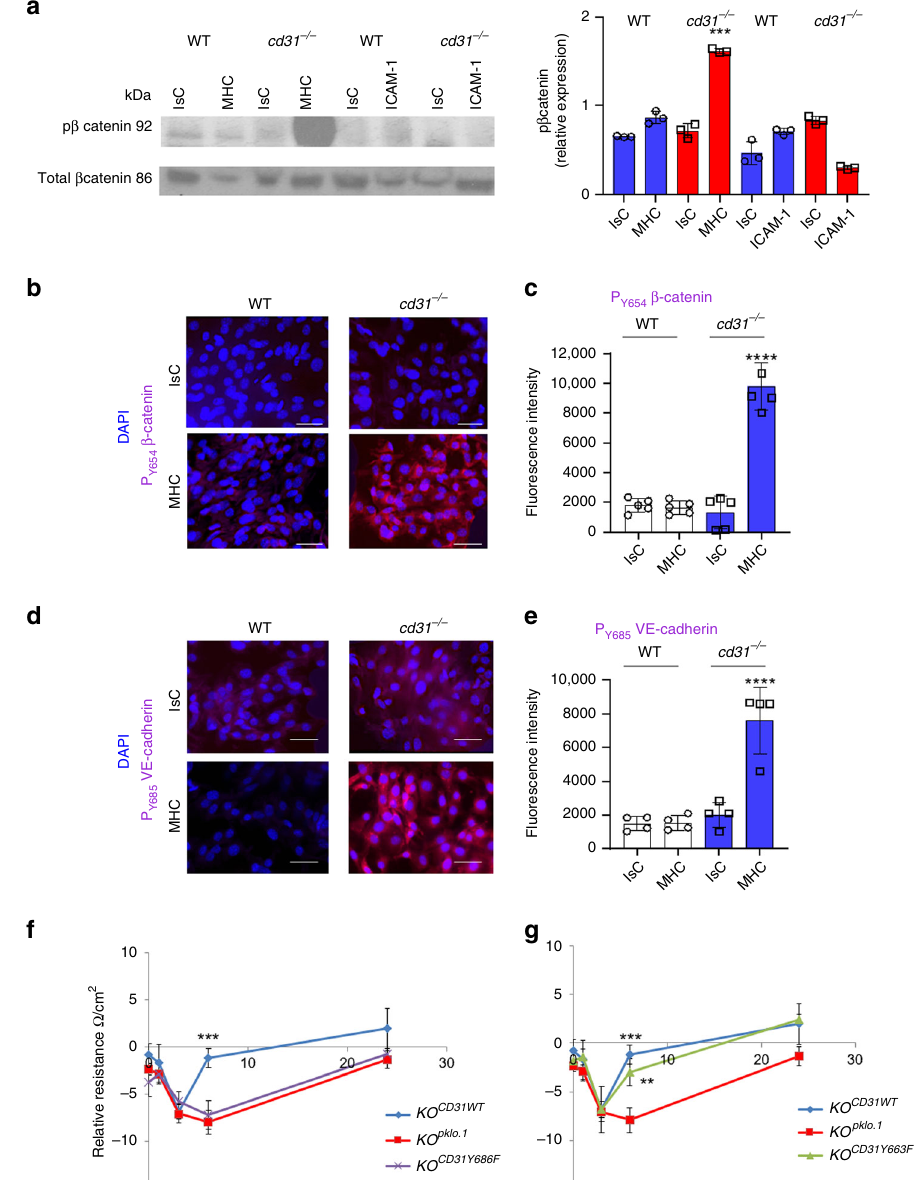
Fig. 2 CD31 signals prevent VE-cadherin and β -catenin phosphorylation in response to MHC stimulation via ITIM 686-thyrosine phosphorylation. a phosphorylation of β -catenin (Y654) by MHC- or ICAM-1-stimulated (30 min) WT or cd31 − / − EC was analyzed by western blotting. The bar graph shows relative protein expression ± SEM. ( N = 3 independent experiments). One-way Anova with Tuckey post-hoc test. cd31 − / − MHC vs all *** p = 0.0002. b – e phosphorylation of β -catenin (Y654, b ) or VE-cadherin (Y685, d ) by MHC-stimulated (30 min) WT or CD31 − / − EC was analyzed by wide fi eld fl uorescence microscopy. The bar graphs c , e show the mean fl uorescence intensity/per cell of the indicated marker measured in three independent experiments by ImageJ software. Scale bar, 20 μ m. Magni fi cation ×20. Data are mean ± SD. One-way Anova with Tuckey post-hoc test. c cd31 − / − MHC vs all **** p < 0.0001; e cd31 − / − MHC vs all **** p < 0.0001. f , g CD31 gene constructs with mutations leading to the loss-of-function